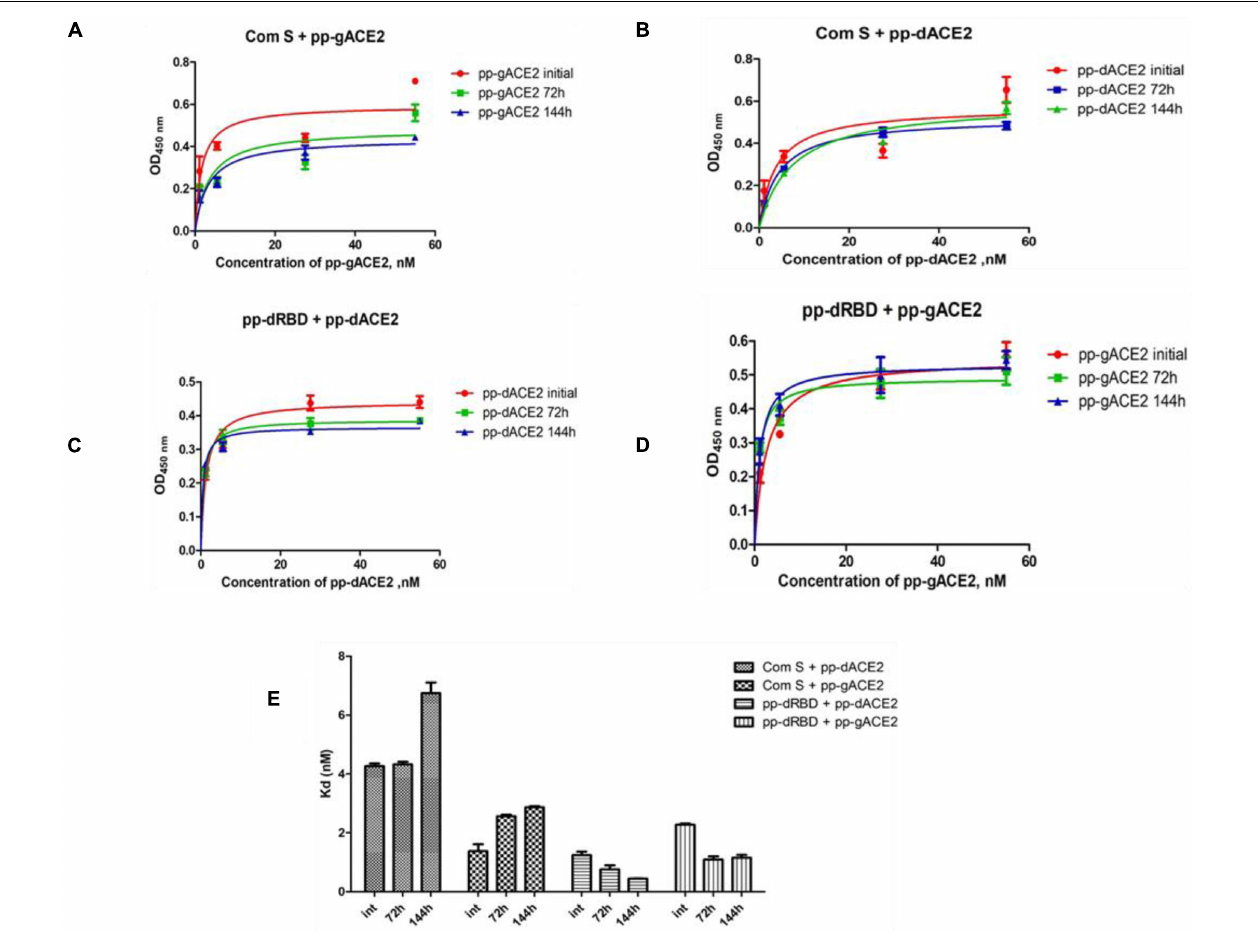
FIGURE 6 | Binding affinity of plant produced gACE2 and dACE2 proteins after incubation at 37 ◦ C for 72 and 144 h. Plant produced gACE2 or dACE2 proteins incubated at 37 ◦ C for 72 and 144 h were used for ELISA to analyze binding affinity to commercial S-protein (Com S) or dRBD. (A–D) A Graph was plotted with the non-linear regression analyses in GraphPad software. Points refer to absorbance for each sample dilution and lines were plotted according to Kd value. (E) Column bar graph of Kd values determined with the non-linear regression analyses in GraphPad